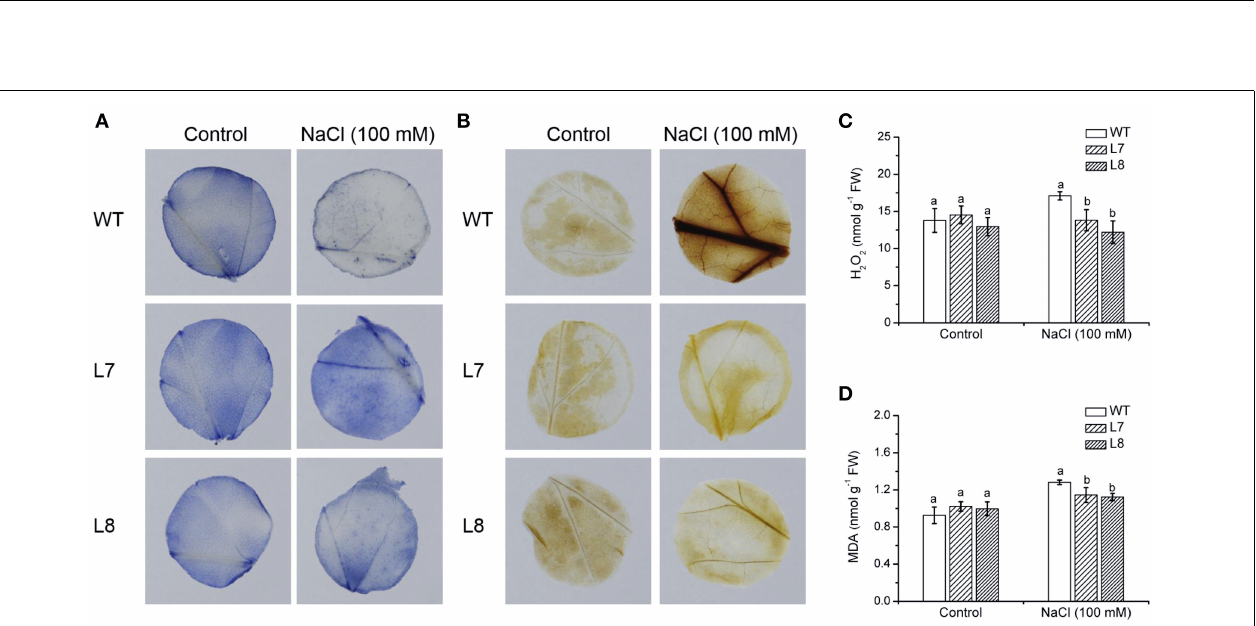
FIGURE 8 | Effects of NaCl on leaf ROS and malondialdehyde levels in wild-type tobacco and KcCSD -transgenic lines. Four-weeks old rooted plants of wild-type (WT) and transgenic lines (L7 and L8) were transferred to 1/4 Hoagland’s nutrient solution for 2-weeks acclimation, then exposed to 0 or 100mM NaCl for 7 days. Leaf discs (2cm in diameter) were sampled. (A)